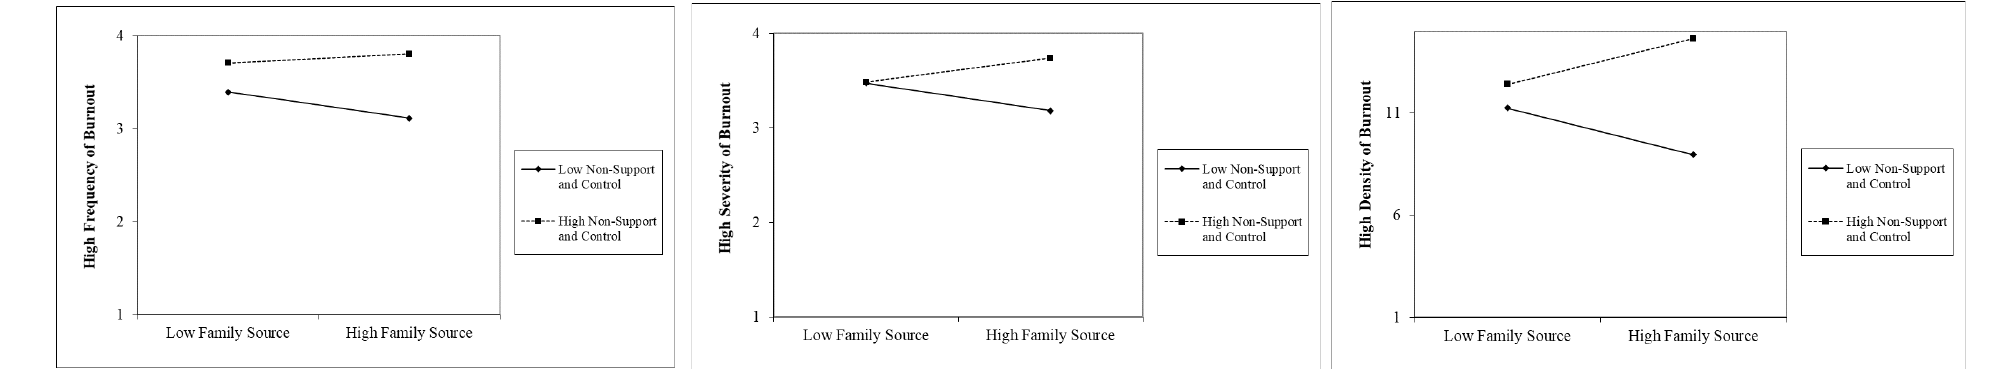
Figure 2. Significant Interactions for Low Frequency, Low Severity and Low Density.